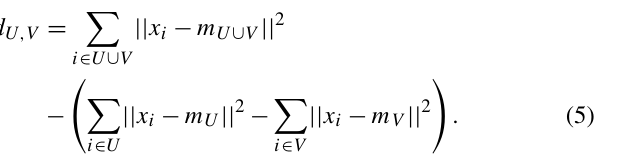
detected during 4